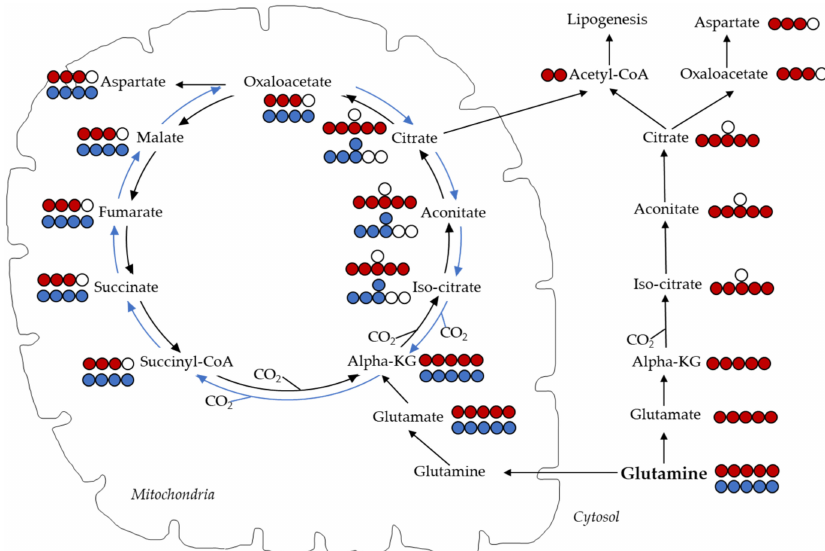
Figure 2. Carbon labelling TCA cycle intermediates and aspartate from U- 13 C glutamine via oxidative (carbon marked with blue) and reductive carboxylation (carbon marked with red) pathway. Oxidative glutaminolysis generates M + 4-labeled TCA cycle intermediates while reductive carboxylation generates M + 5 citrate followed by M + 3 malate, fumarate, succinate and